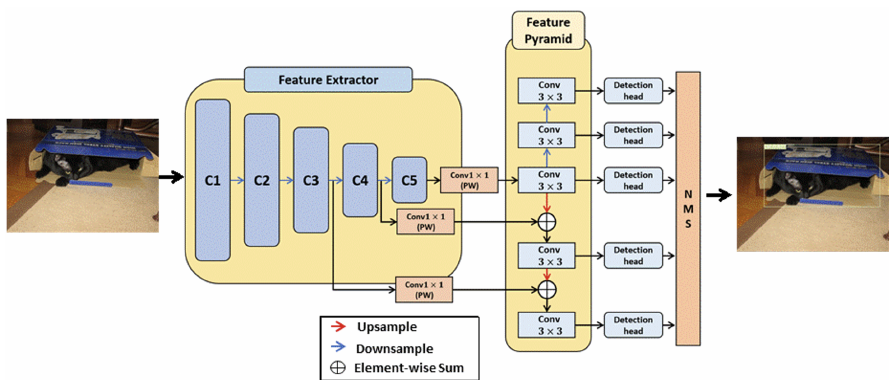
Figure 1. Structure of the fully convolutional one-stage detector. It uses ResNet-50 [18] as the backbone and has the structure of an object detection network using a feature pyramid [19] structure.